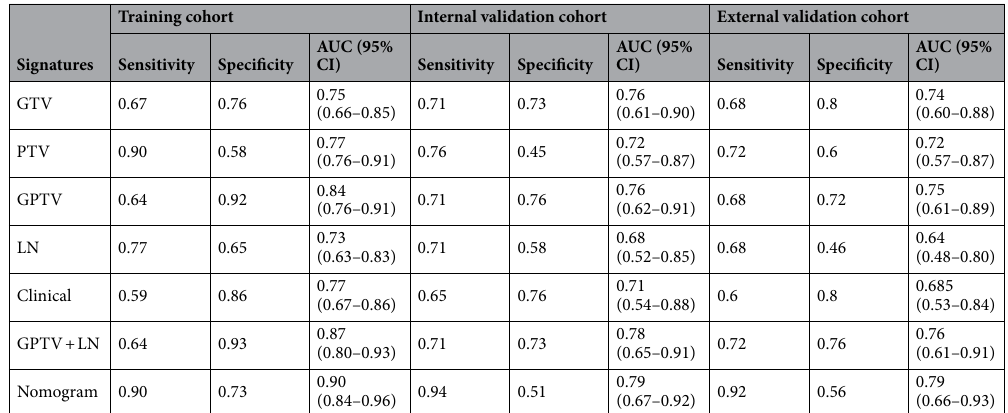
Table 2. Diagnostic performance of radiomics signatures and nomogram. GTV gross tumor volume, PTV peritumoral volume, GPTV gross and peritumoral volume, LN lymph node, AUC area under